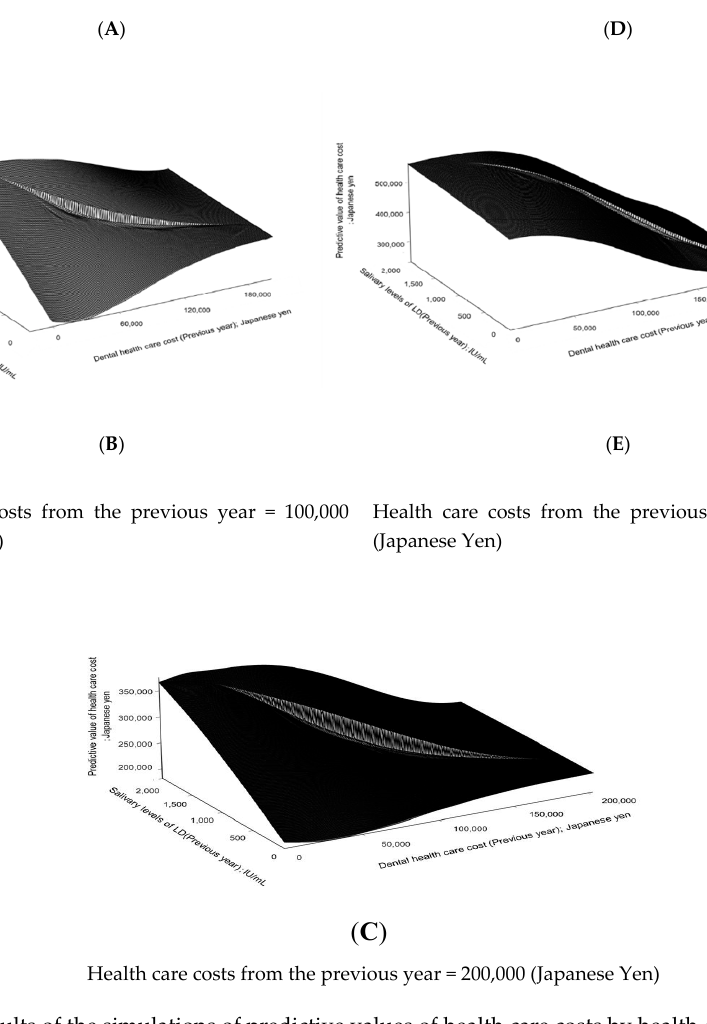
Figure 4. Results of the simulations of predictive values of health care costs by health care costs, dental health care costs, and salivary levels of